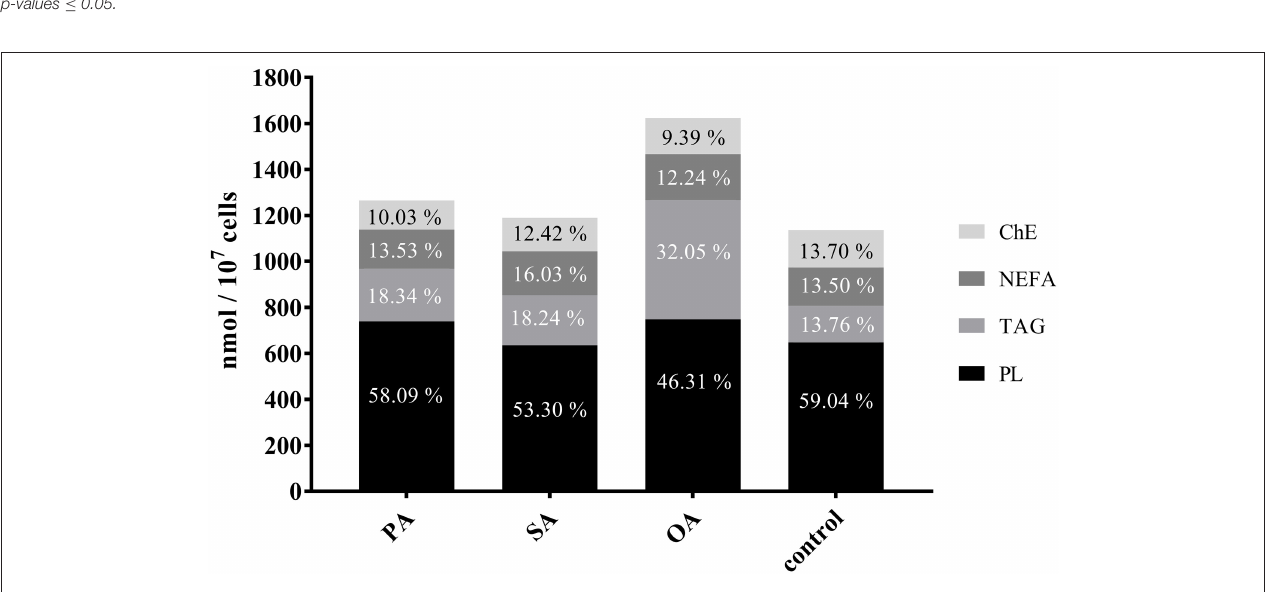
FIGURE 4 | Proportion of lipid classes in control and treated cells. Bars show the total fatty acids in nmol FAs/10 7 cells. For comparability, the proportions of the lipid classes (ChE, cholesterol esters; NEFA, non-esterified fatty acids; TAG, triacylglycerides; PL, phospholipids) are indicated. PA, palmitic acid; SA, stearic acid; OA, oleic